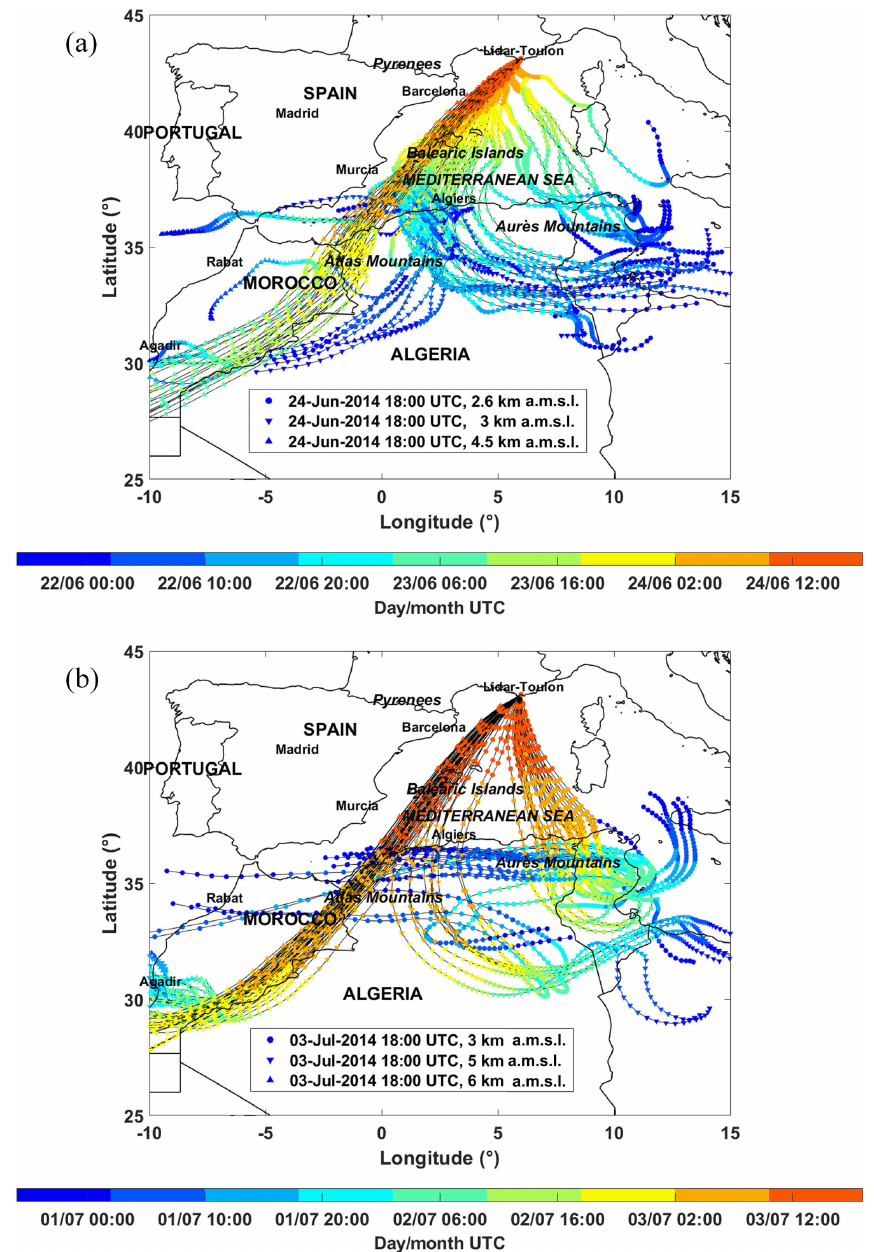
Figure 13. 3-day back trajectories from the French Riviera (Toulon; 43.13556 ◦ N, 6.00944 ◦ E). The altitudes of the end locations of the air mass trajectories are in the main dust plumes detected by the ground-based N 2 -Raman lidar on (a) 24 June 2014 for end locations of 2.6, 3, and 4.5km, (b) 3 July 2014 for end locations of 3, 5, and 6km. The HYSPLIT model worked in its ensemble mode, i.e., 27 back trajectories computed for each end